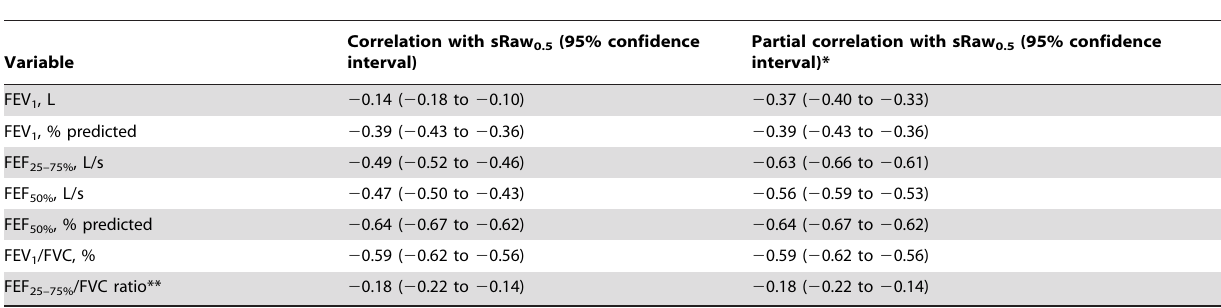
Table 2. Relationship between sRaw 0.5 and forced expiratory flow rates as assessed by Spearman’s signed rank test.